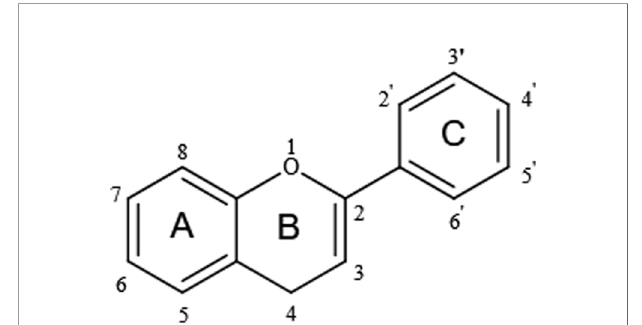
FIGURE 2 | Basic structure of fl